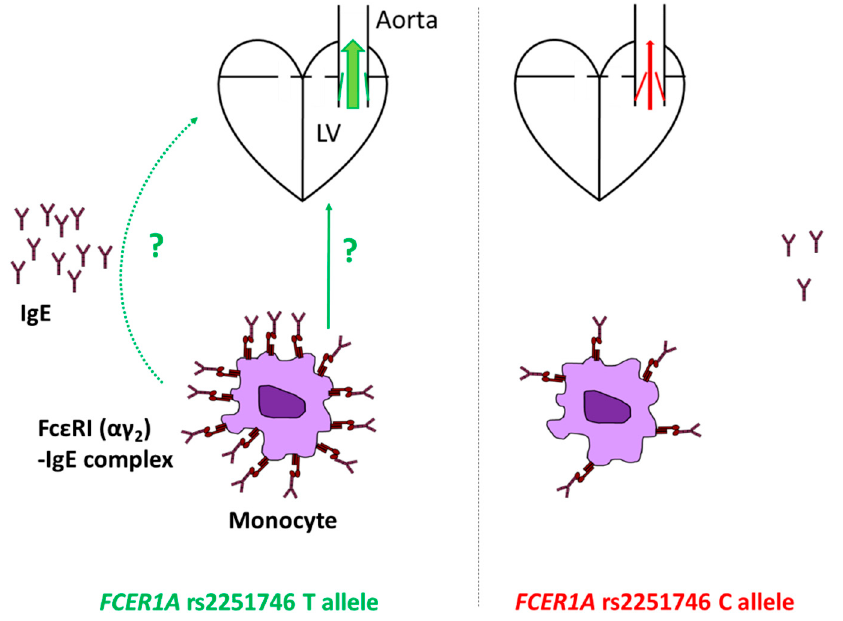
Figure 3. Schematic illustration of the finding and hypothetical mechanism(s) underlying it. The T allele of the high-affinity immunoglobulin E (IgE) receptor (Fc ε RI) α -subunit (Fc ε RI α ) gene ( FCER1A ) rs2251746 polymorphism is associated with larger aortic valve area and thus less severe aortic valve stenosis. The mechanism behind it is unknown but might involve monocytes and their enhanced functions resulting from higher surface Fc ε RI( α ) expression. Serum IgE might also contribute or be a bystander with potential marker properties. LV denotes left ventricle.